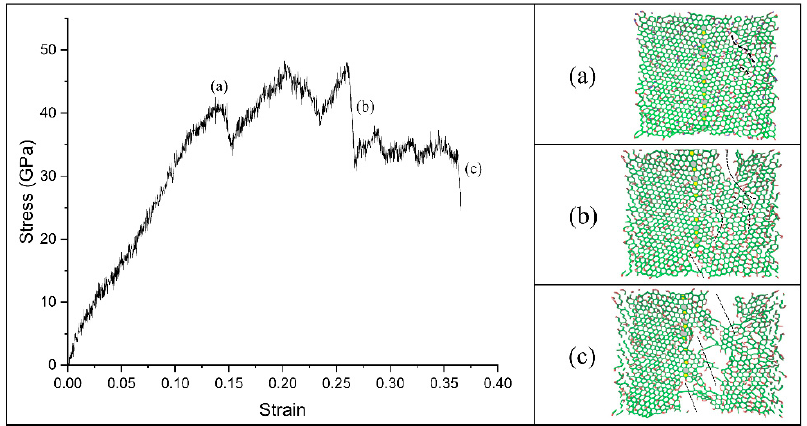
Figure 6. Tensile stress-strain curve and dynamic fracture process of PGO under the strain rate of 1 × 10 − 5 fs − 1 . ( a ) PGO at strain of 0.14; ( b ) PGO at strain of 0.26; ( c ) PGO at strain of 0.36.